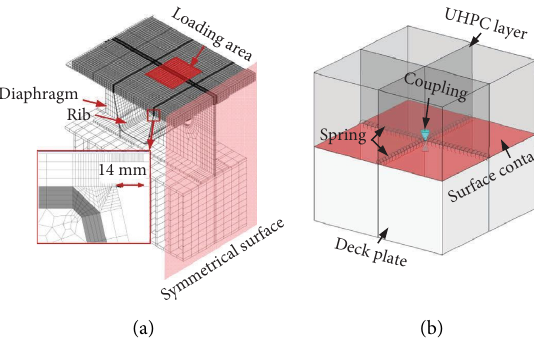
Figure 23: FE model of transverse specimen: (a) overview of FE model and (b) the connection between the deck plate and the UHPC layer.